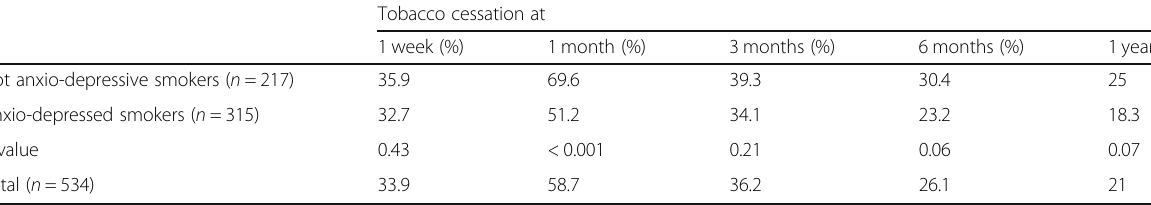
Table 4 Distribution of smokers according to the time of tobacco cessation Tobacco cessation